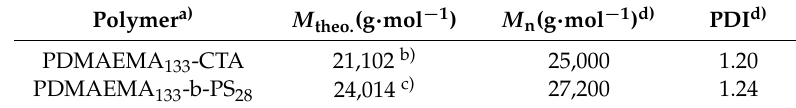
Table 1. Characteristics of the PDMAEMA-CTA and PDMAEMA-b-PS block copolymers. Polymer